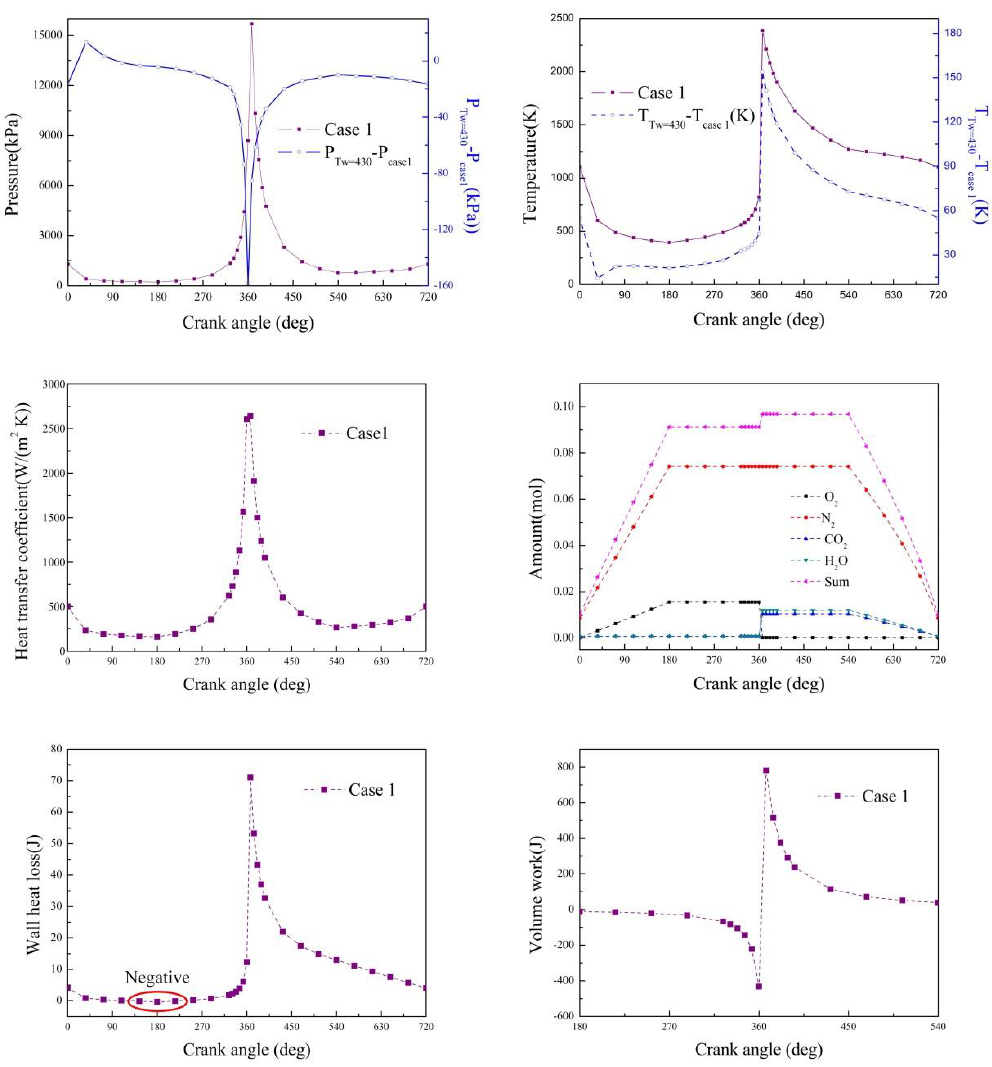
Figure 5. Simulation value of combustion.